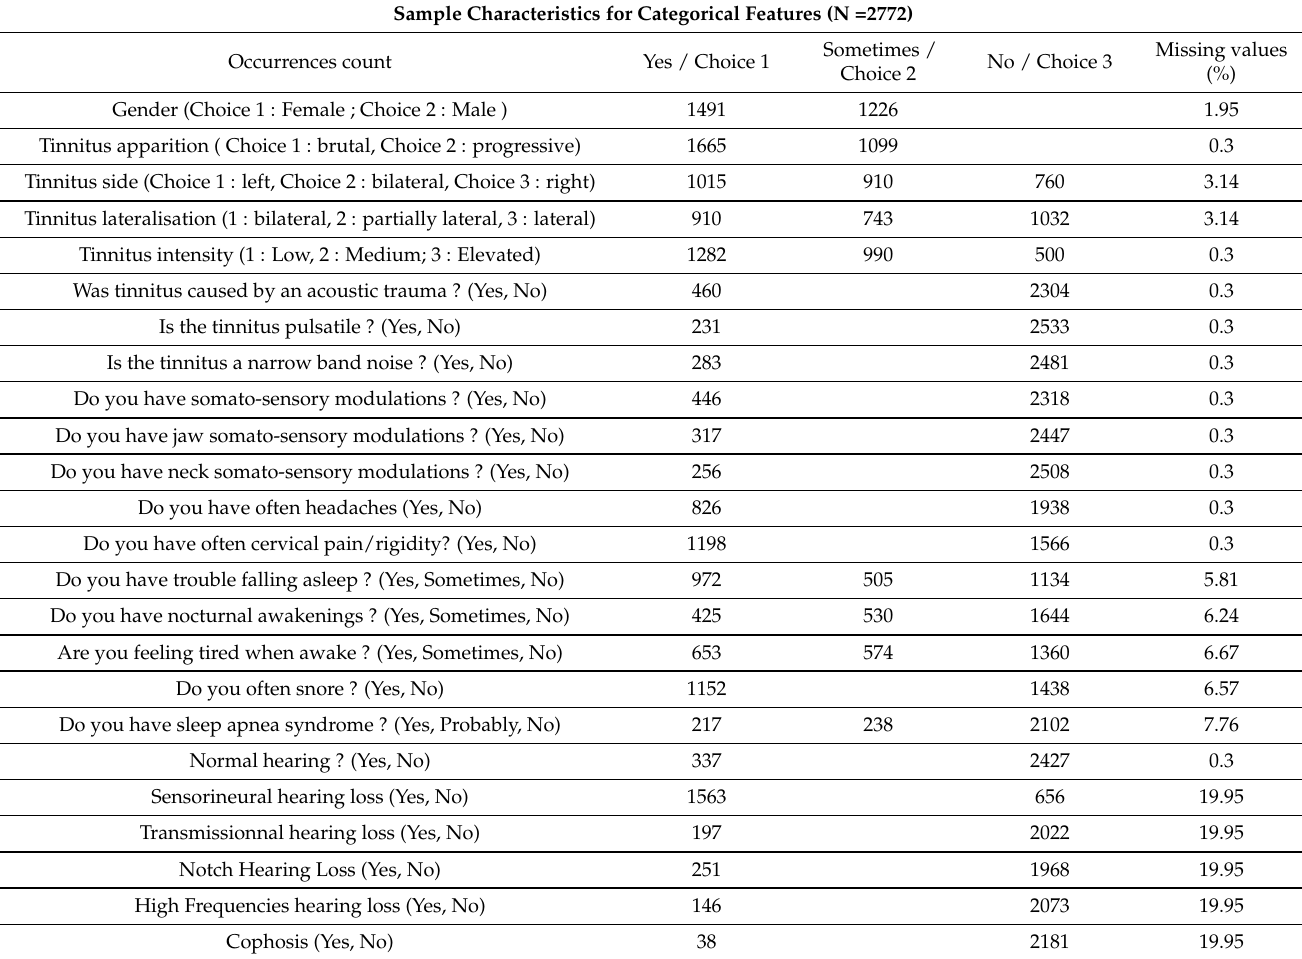
Table 3. Sample characteristics: categorical features of the preprocessed database. Sample Characteristics for Categorical Features (N =2772)